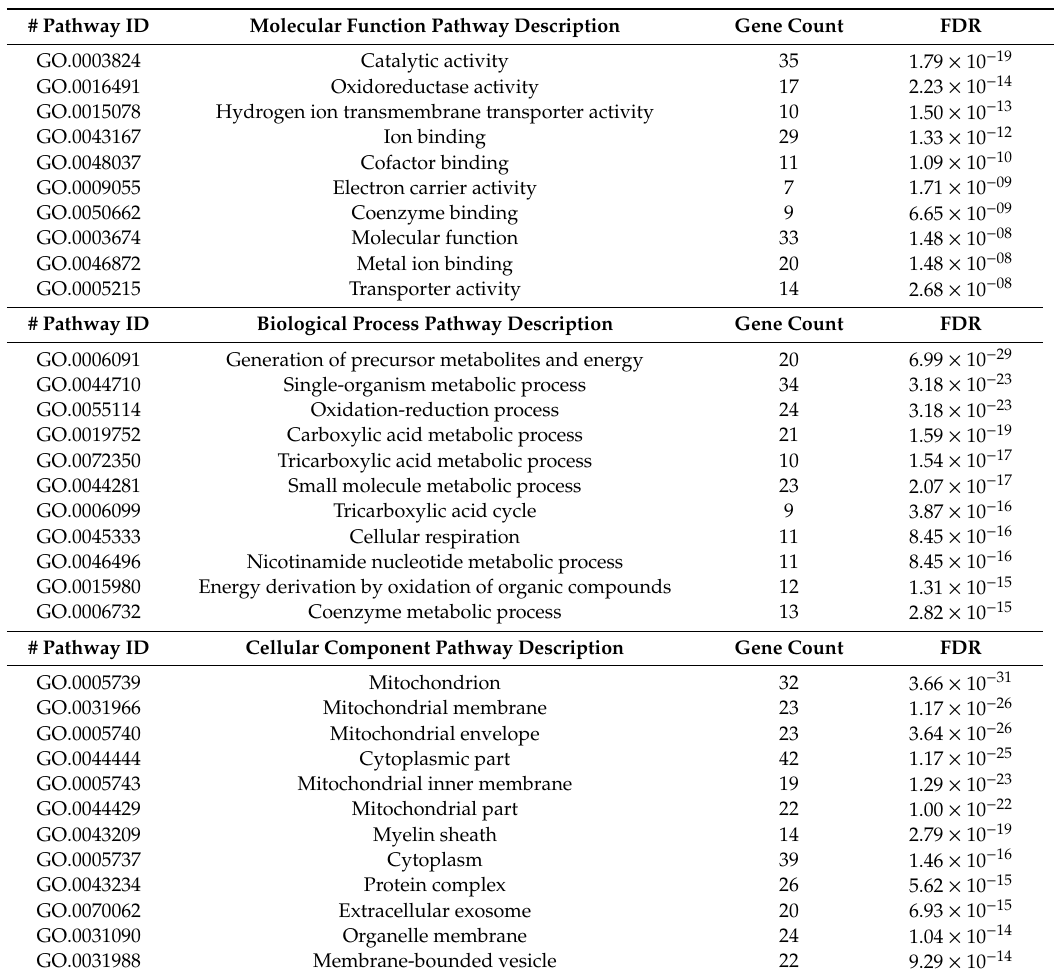
Table 3. The most impacted molecular function, biological processes and cellular components in muscle proteomic analyses identified in rats with Walker tumour-bearing fed / not fed a leucine-rich diet and euthanatised at 21st day of the